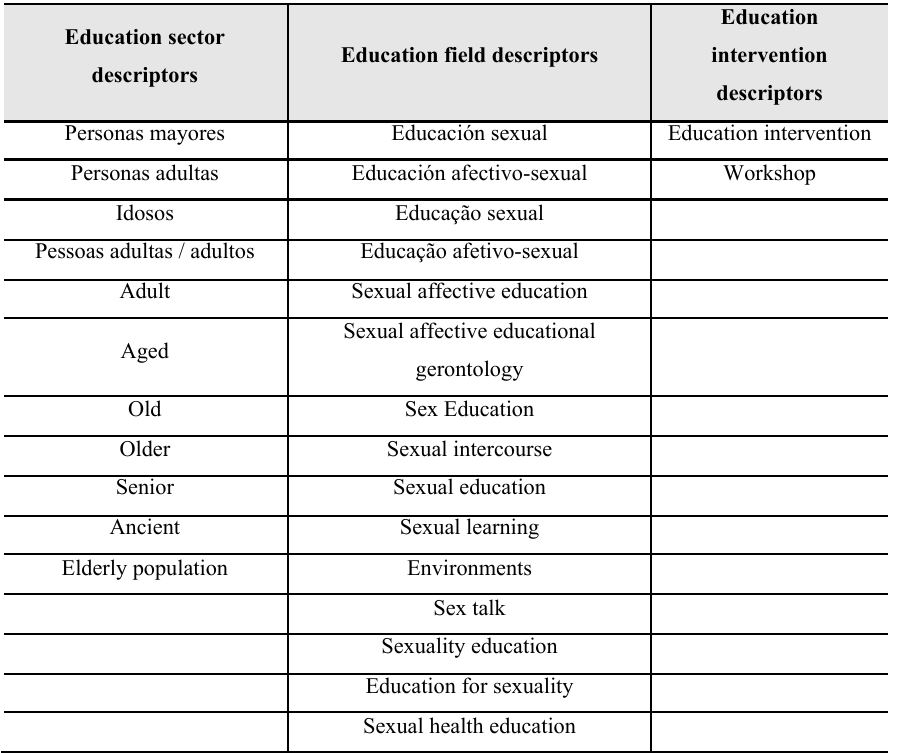
Table 1. Descriptors used in the literature